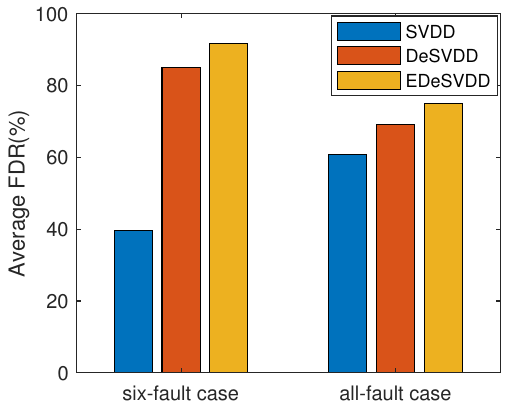
Figure 11. Comparison of average FDR.